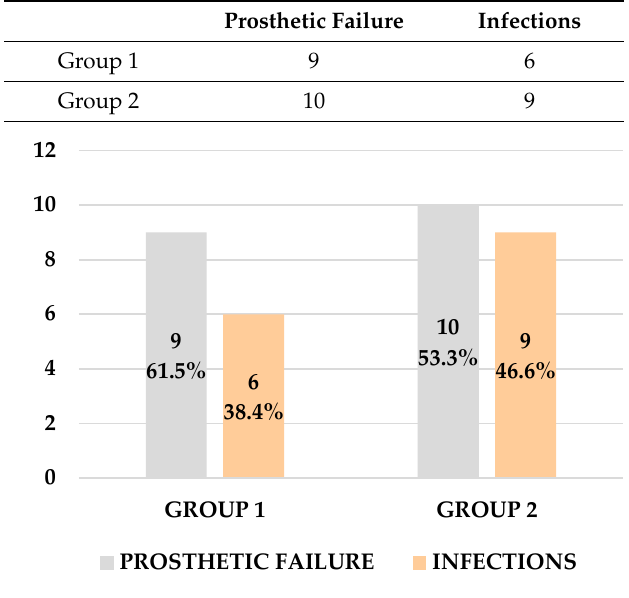
Table 4. Etiology for each extraction.